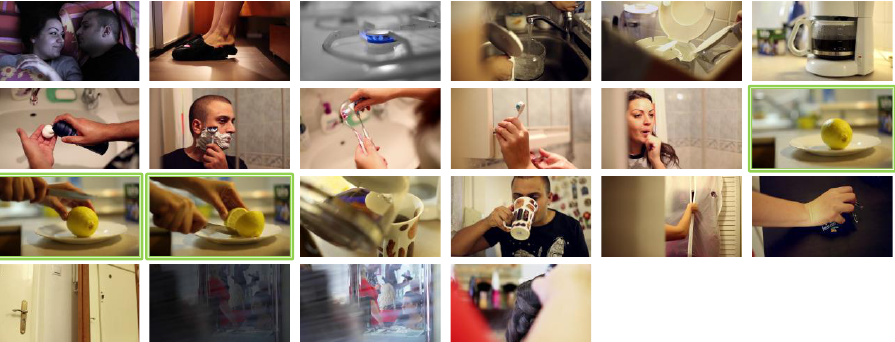
Figure 10. Example of the ground-truth keyframes for a 20 s video clip used as a KIS task at VBS2019. During the competition, our team correctly found the target video by formulating a query describing one of the keyframes depicting a lemon. However, note that most of the keyframes in the ground- truth were not relevant for the specific query submitted to our system as only three keyframes (outlined in green in the figure) represented the scene described in the query (yellow lemon in the